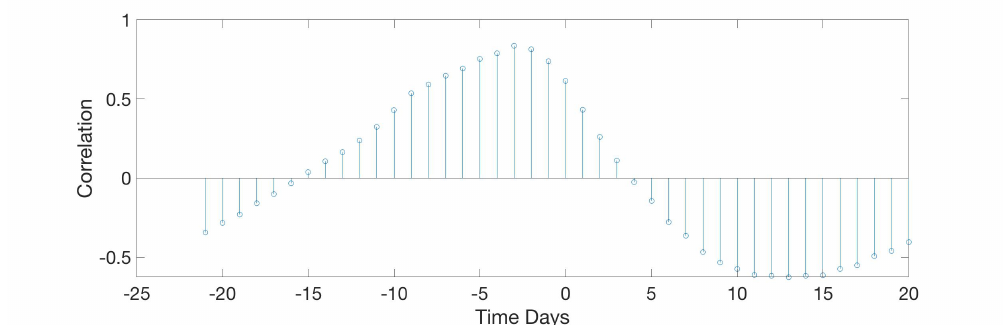
Figure 22. Results of the circular correlation food—weight. Horizontal axis corresponds to the time (in days), evaluating the delay between the food intake and the mean weight of the